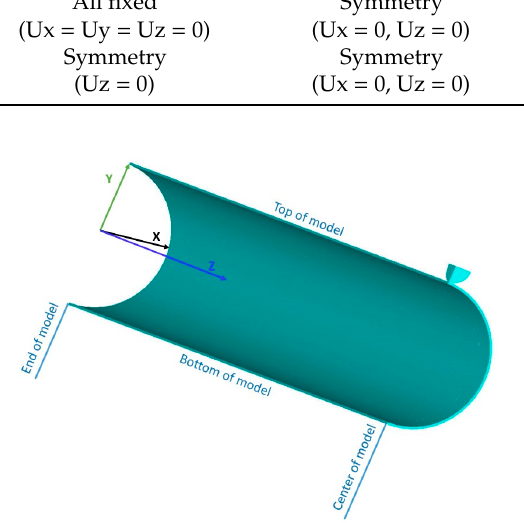
Figure 2. FEA model to describe boundary conditions.